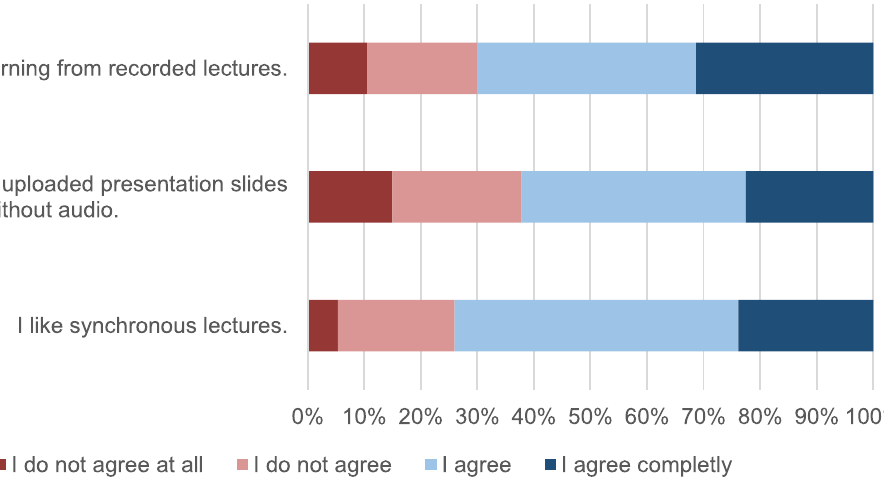
FIG. 2. Preferences for different course